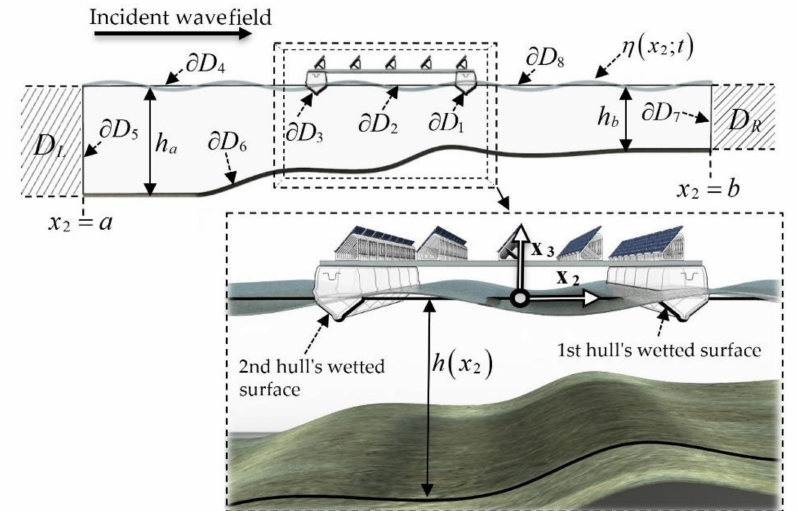
Figure 1. Geometric configuration of the 2D